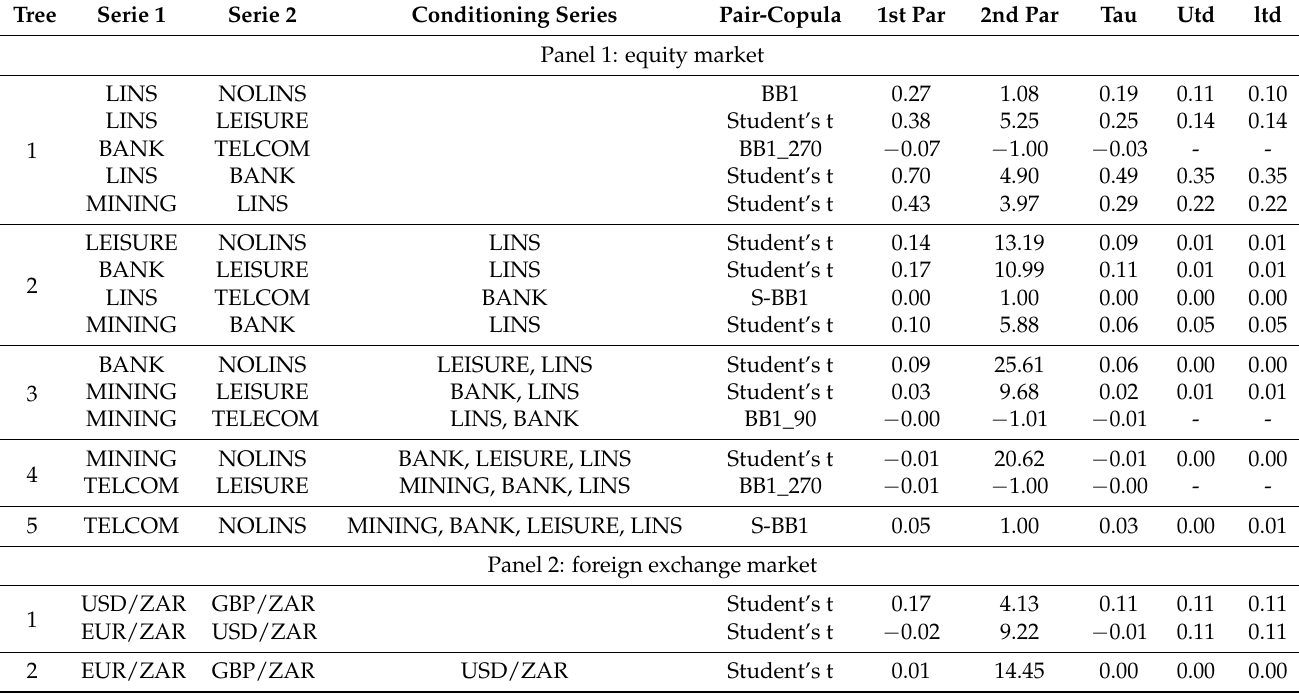
Table A1. Parameter estimates of the dependence structures using R-vine